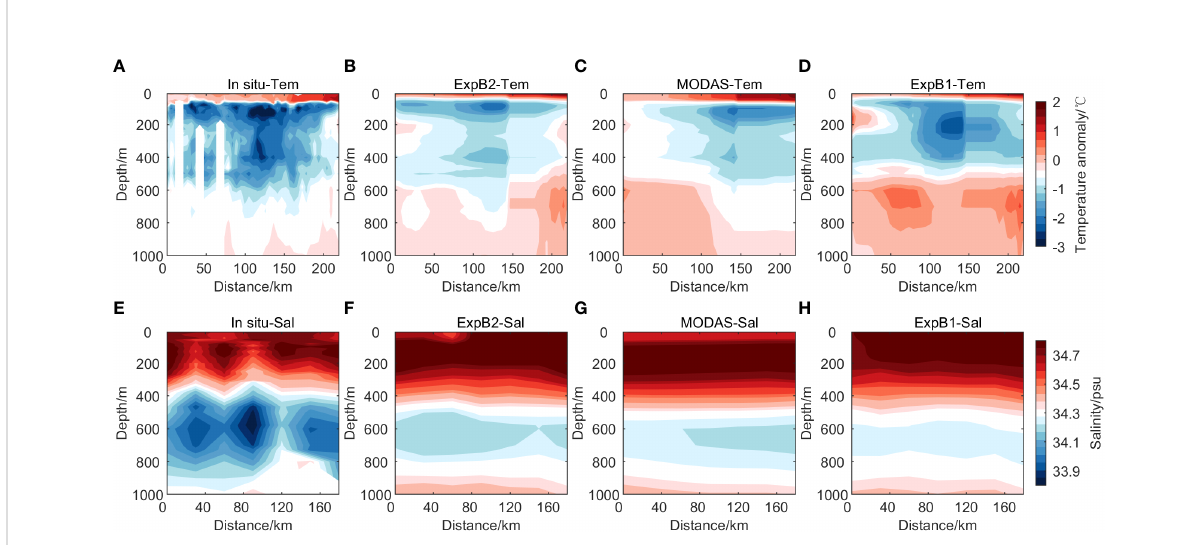
FIGURE 9 Temperature anomaly section and salinity section along the observation route. From top to bottom: temperature anomaly values and salinity values. (A, E) in-situ survey data, (B, F) the experiment results of assimilating the synthetic T/S observations, (C, G) the MODAS data of the National Marine Data Center, (D, H) the experiment results of assimilating the satellite observations. The abscissa represents the distance from the starting point of the survey data (unit: km).